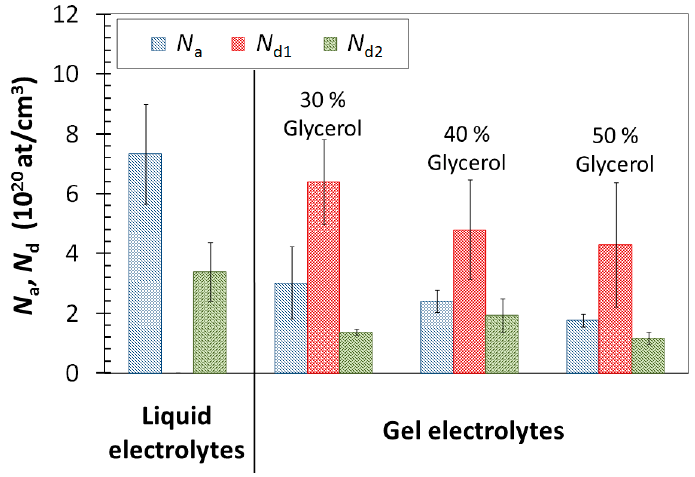
Figure 7. Effect of liquid and gel electrolytes with 1% KClO 4 on acceptor densities ( N a ) and donor densities ( N d ) for the compounds comprising the passive layer.